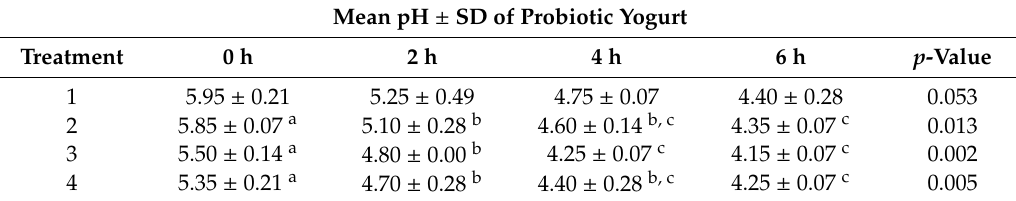
Table 3. Mean pH (Mean ± SD) of probiotic yogurt treatments containing Lactobacillus rhamnosus GR-1 following 0, 2, 4, and 6 h of